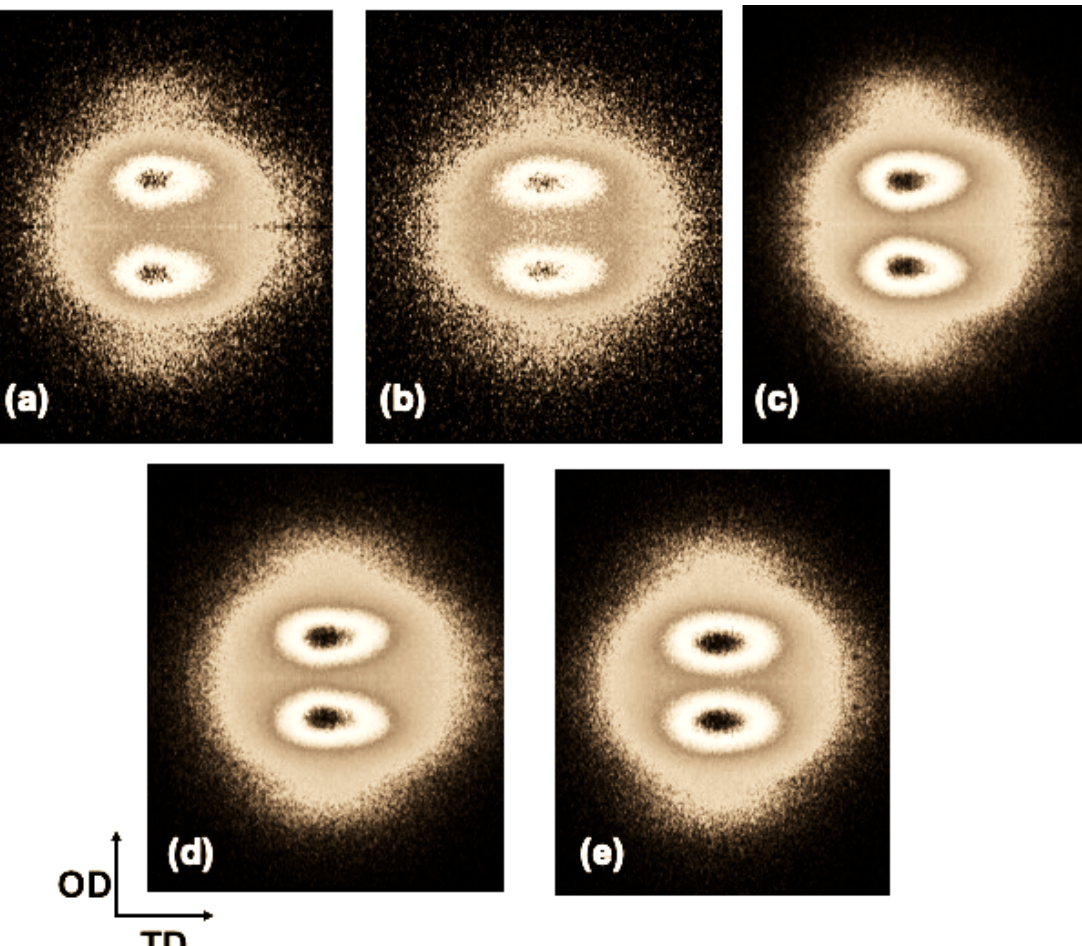
Figure 8. 2D SAXS patterns of the iPP probes injected at different conditions: ( a ) PP-80%-3 s, ( b ) PP-80%-5 s, ( c ) PP-80%-6 s, ( d ) PP-90%-6 s, and ( e ) PP-100%-6 s.